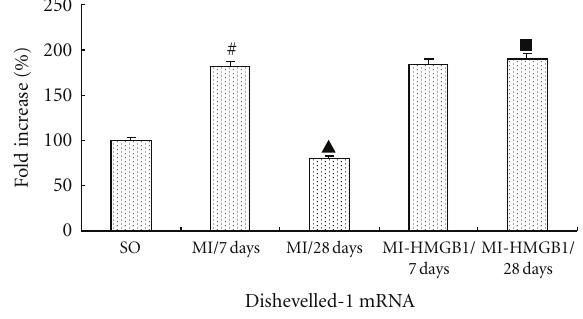
Figure 2: Expressions of dishevelled-1 mRNA at di ff erent time points in di ff erent experimental groups ( n = 5 for each group). # P < 0 . 05 versus SO group; (cid:2) P < 0 . 05 versus MI/7 days; (cid:3) P < 0 . 05 versus MI/28 days. Abbreviations are identical with Figure 1.